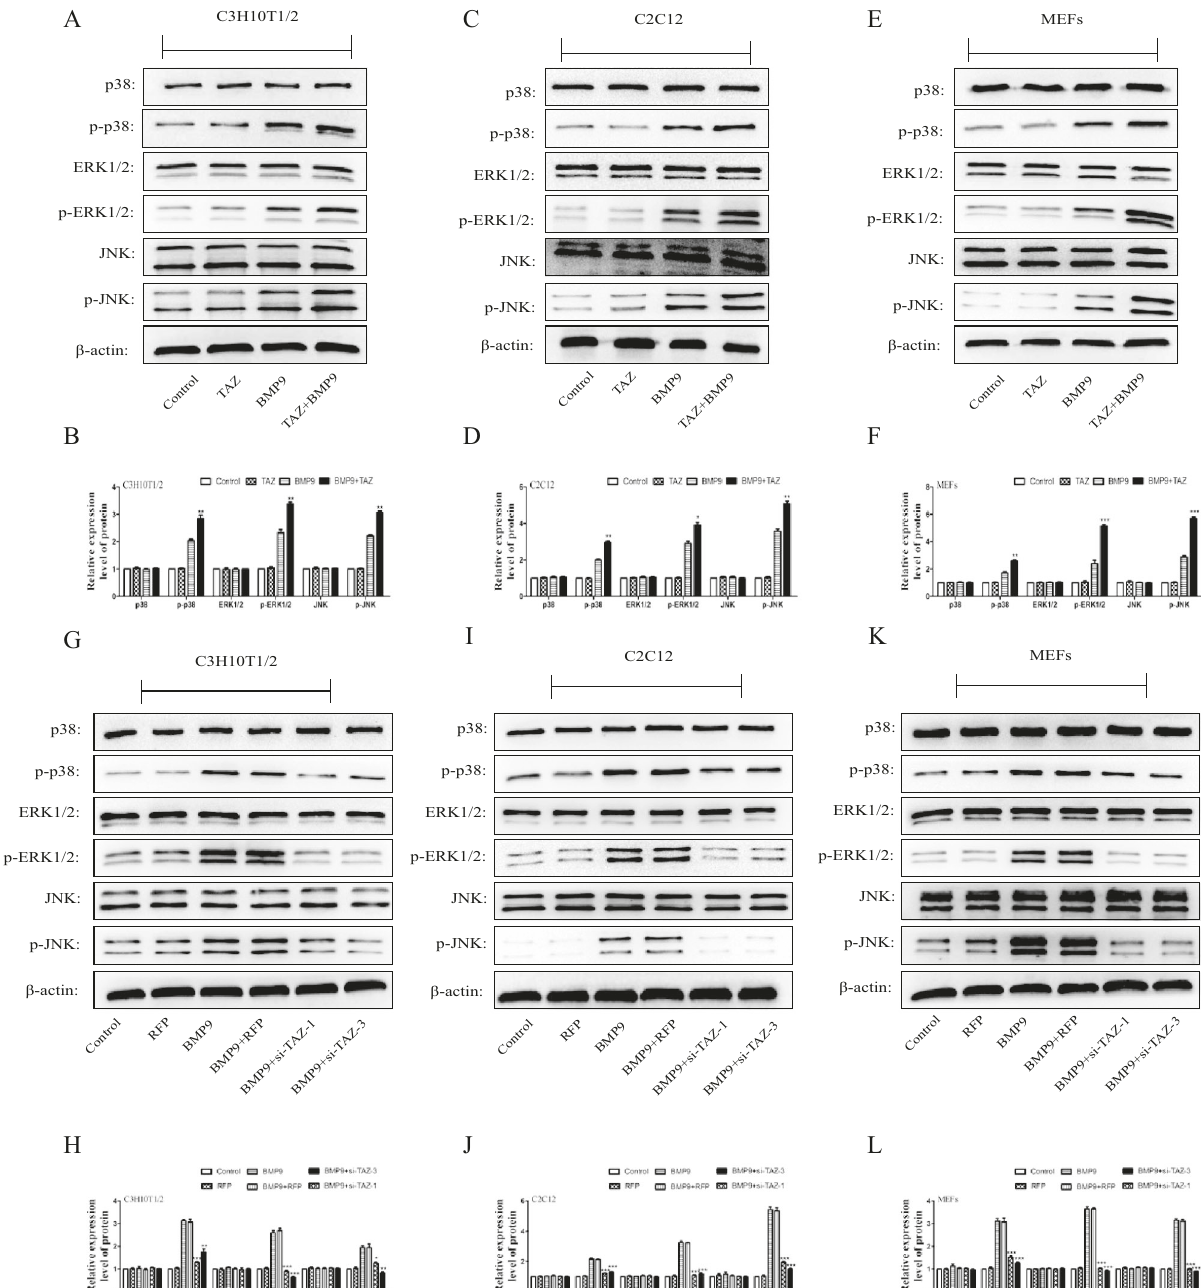
Fig. 6 The effect of TAZ on BMP9-induced MAPKs in MSCs and MMCs. Cells were treated with TAZ or si-TAZ, followed by treatment with BMP9. A – L The total amount of p38, ERK1/2, and JNK and the phosphorylated forms of p38, ERK1/2, and JNK were measured by western blot. The data were shown as mean ± SD for three separated experiments. ( *P < 0.05 , **P < 0.01 , ***P < factors, and subcutaneous ectopic osteogenesis. Our results synergistic effect with BMP9 in osteogenic differentiation of MSCs demonstrated that TAZ signi fi cantly promoted the early and late needs an answer. osteogenic differentiation induced by BMP9. Moreover, in vivo Our study investigated the effects of TAZ in BMP9 by regulating experiments showed that TAZ promoted the subcutaneous osteogenic of MSCs and MMCs and its potential mechanisms. We ectopic osteogenesis in nude mice. Mechanically, TAZ increased found that BMP9 would increase the expression of TAZ and the levels of phosphorylation of p38, ERK1/2, JNK, and Smad1/5/8, promote its nuclear translocation during the experiment. In the meantime, ChIP experiment con fi rmed that TAZ was a direct target molecule for BMP9/Smad signaling pathway. Following, we studied the effects of TAZ in osteogenic differentiation of MSCs and MMCs induced by BMP9 with using the ALP activity, ALP staining, calcium deposition, expression of osteogenic-related